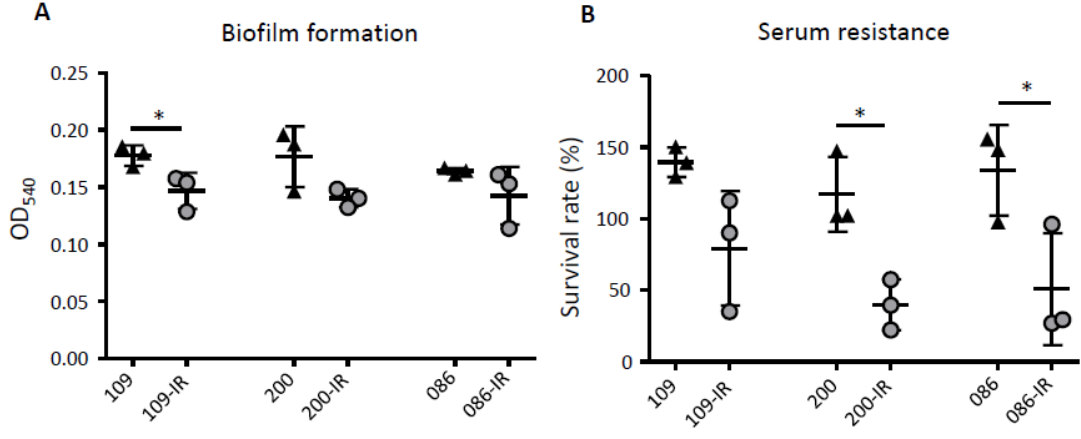
Figure 3. Results of biofilm formation and serum resistance assays. ( A ) Biofilm formation of TGC-S and TGC-IR K. pneumoniae strains. The biofilm was stained with crystal violet and quantified by measuring the absorbance at 540 nm. ( B ) The survival rate of K. pneumoniae strains was determined after 3 h of incubation with human serum. Heat-inactivated serum (HIS) was used as a negative control. *, p < 0.05.